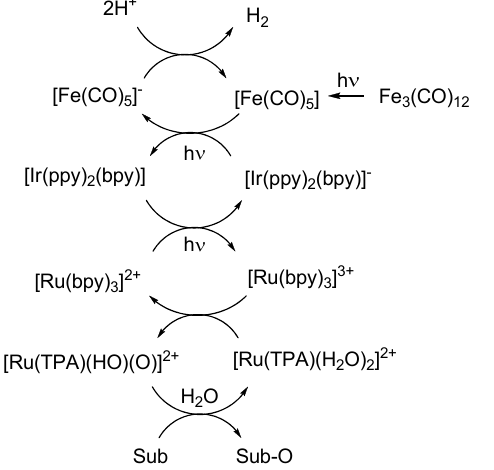
Figure 12. Mechanistic aspects of the hydrogen production coupled to hydrocarbon oxygenation